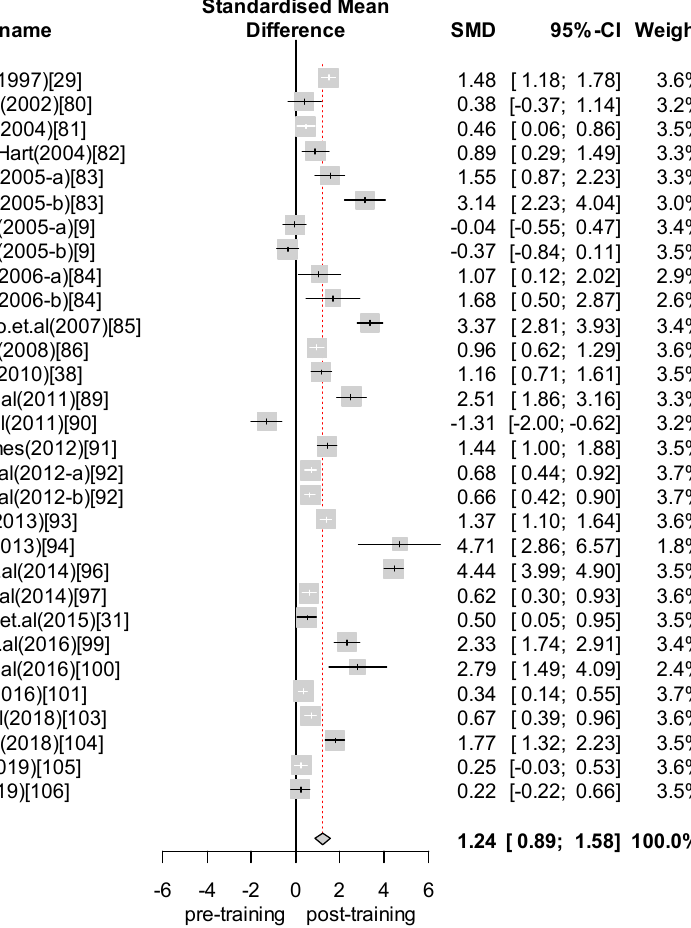
Figure 2. Forest plot—Knowledge.